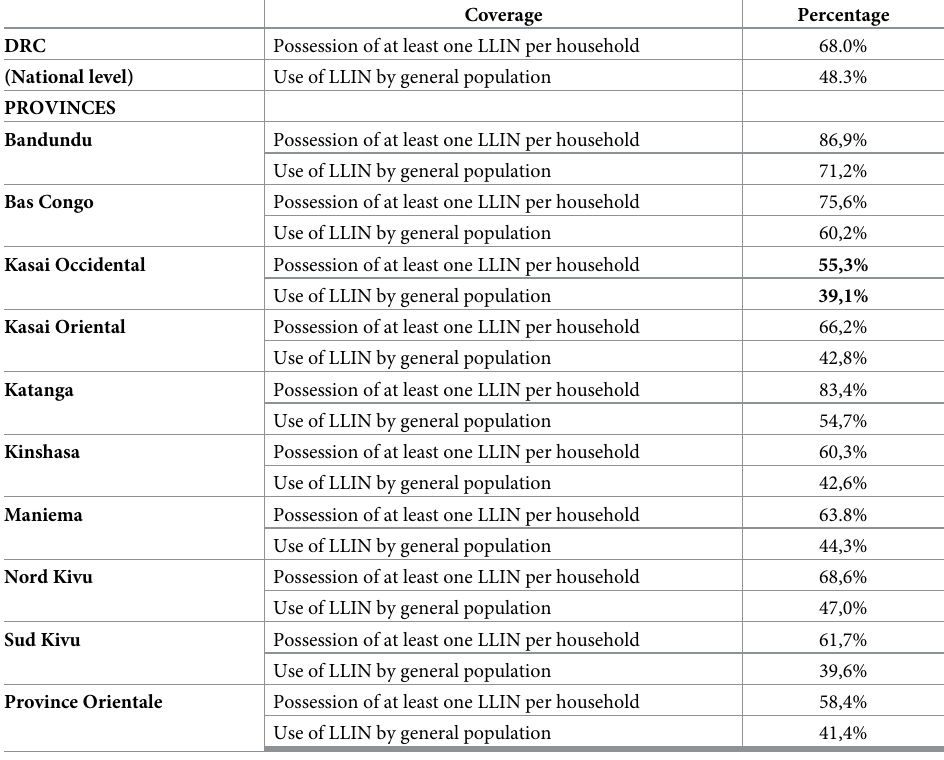
Table 3. Possession per household and use of